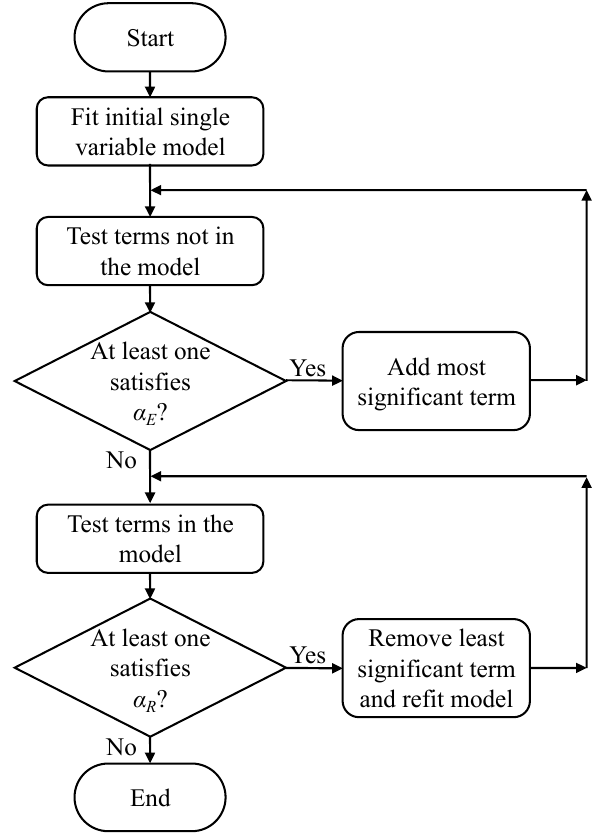
Figure 2. Flow chart of the procedure for stepwise regression.